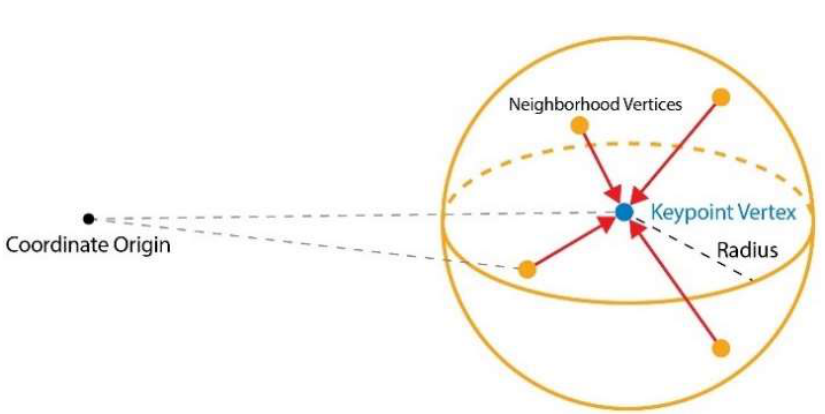
Figure 3. Using the keypoint attention mechanism, the coordinate features of the keypoint aggregate the features of the coordinates of the keypoint and the connected neighbor vertex. Equation (1), which modifies the state of a vertex using the state of a neighbor, is similar to each vector value in terms of direction and